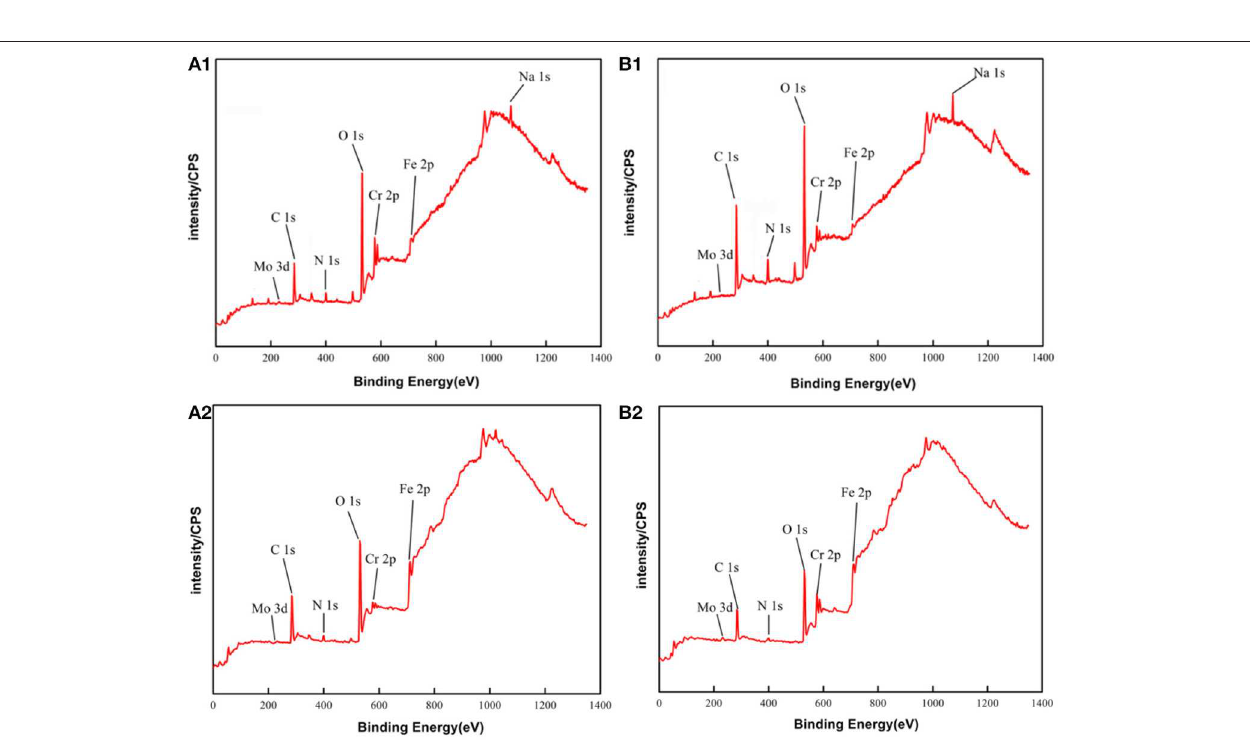
FIGURE 6 | XPS survey spectrum of PH13-8Mo stainless steel: (A1,B1) Bare and pre-passivated sample before exposure; (A2,B2) Bare and pre-passivated sample after 5 year exposure.